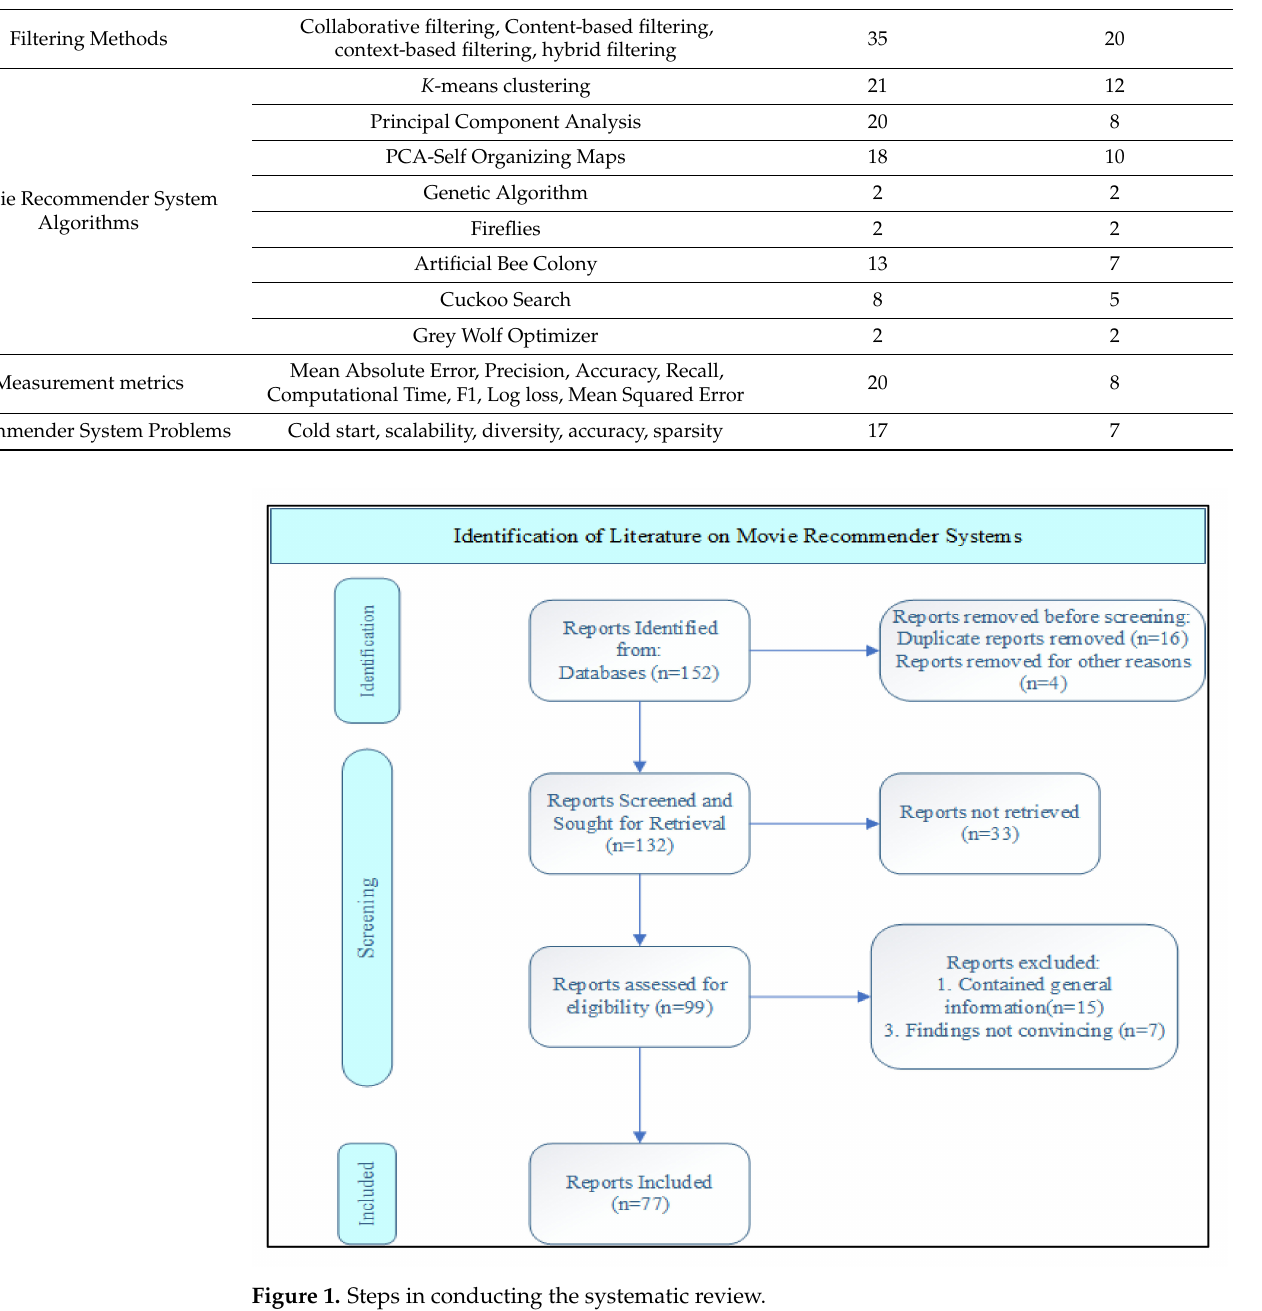
Figure 1. Steps in conducting the systematic